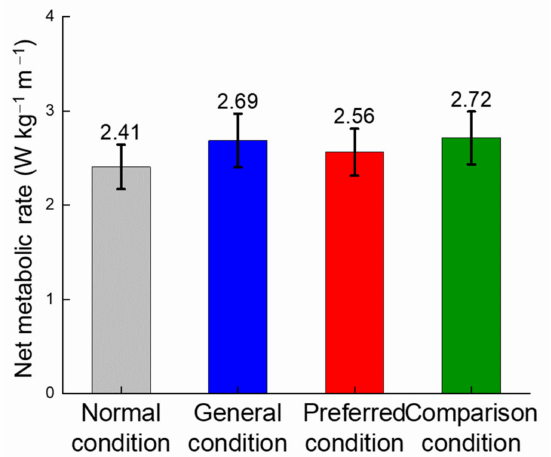
Figure 14. Mean (bars) and standard deviation (whiskers) of the net metabolic rate measured during walking under the normal condition (light grey), general condition (blue), preferred condition (red) and comparison condition (green).